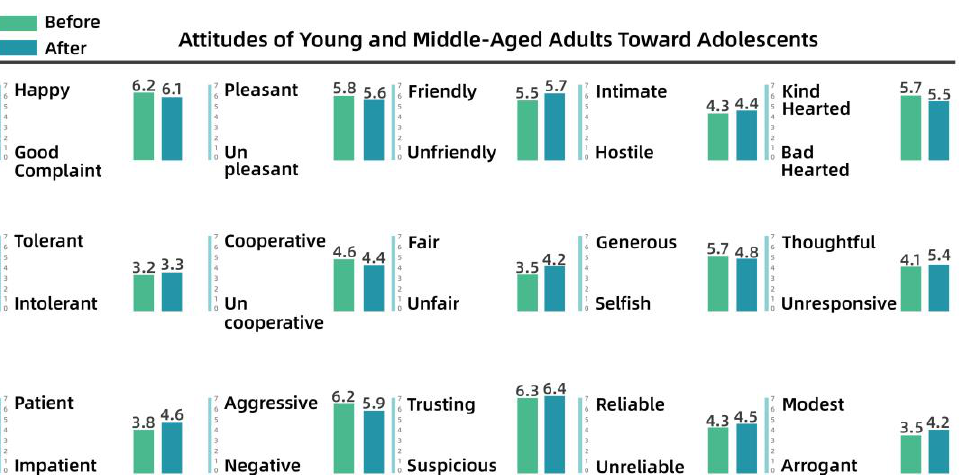
Figure 11. Attitudes of young and middle-aged adults toward older people. (3) Semantic scale results for older people’s attitudes toward younger age groups, young and middle-aged people Figures 12 and 13 show that although some older people were in conflict with other groups over public space issues, their overall attitudes were more positive, with low var- iability before and after the intervention. This led to further consideration of whether older adults had positive perceptions of others. In fact, some residents reported that some older